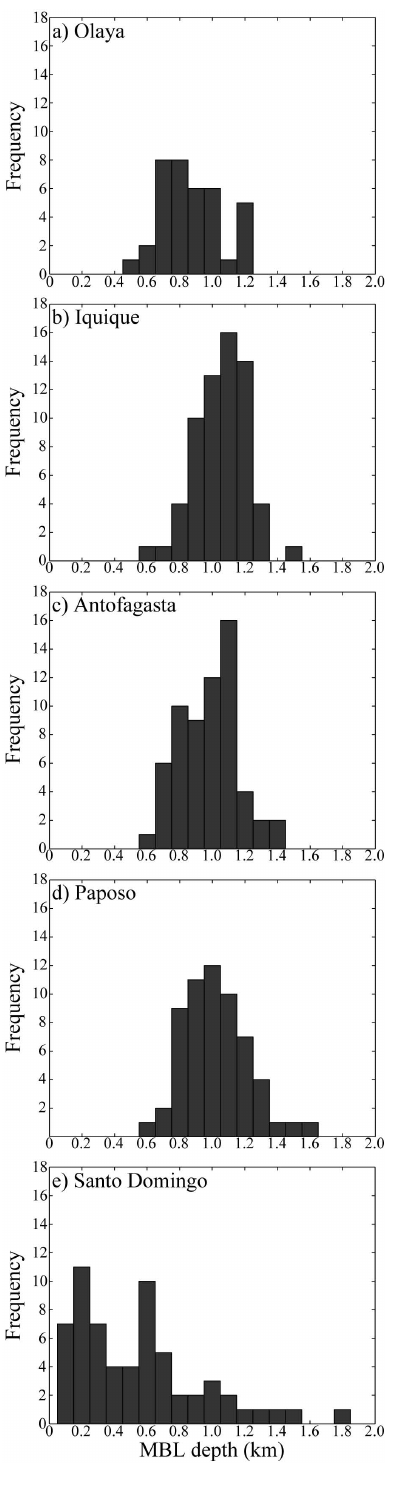
Fig. 5. Frequency of MBL depth for 100-m bins during VOCALS- REx for the costal sites (a) R/V Jos´e Olaya ( ∼ 15 ◦ S), (b) Iquique (20.2 ◦ S), (c) Antofagasta (23.5 ◦ S), (d) Paposo (25 ◦ S), and (e) Santo Domingo (33 ◦ S) using 00:00 and 12:00UTC